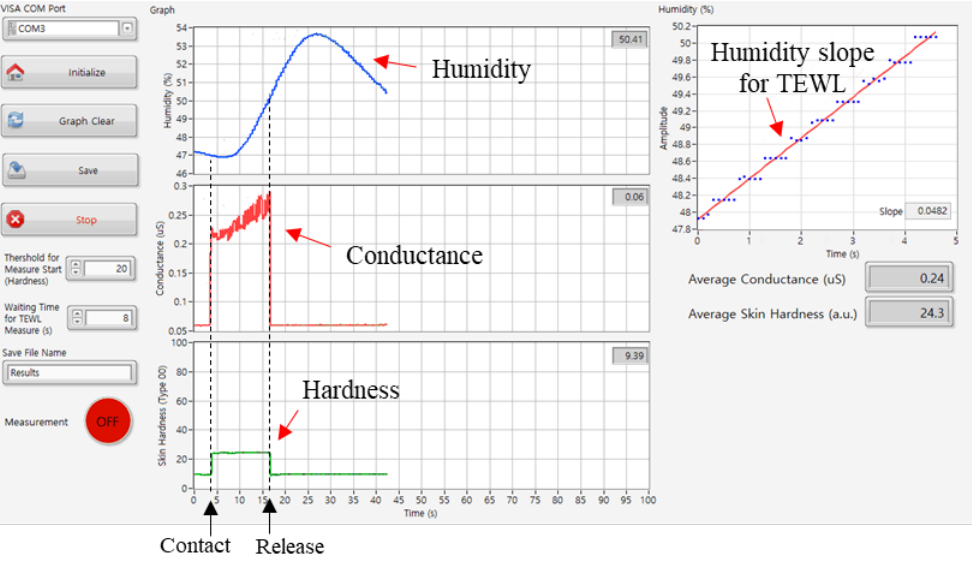
Figure 6. Demonstration of simultaneous measurement of the three different skin properties of TEWL, skin conductance, and skin hardness, in real-time.